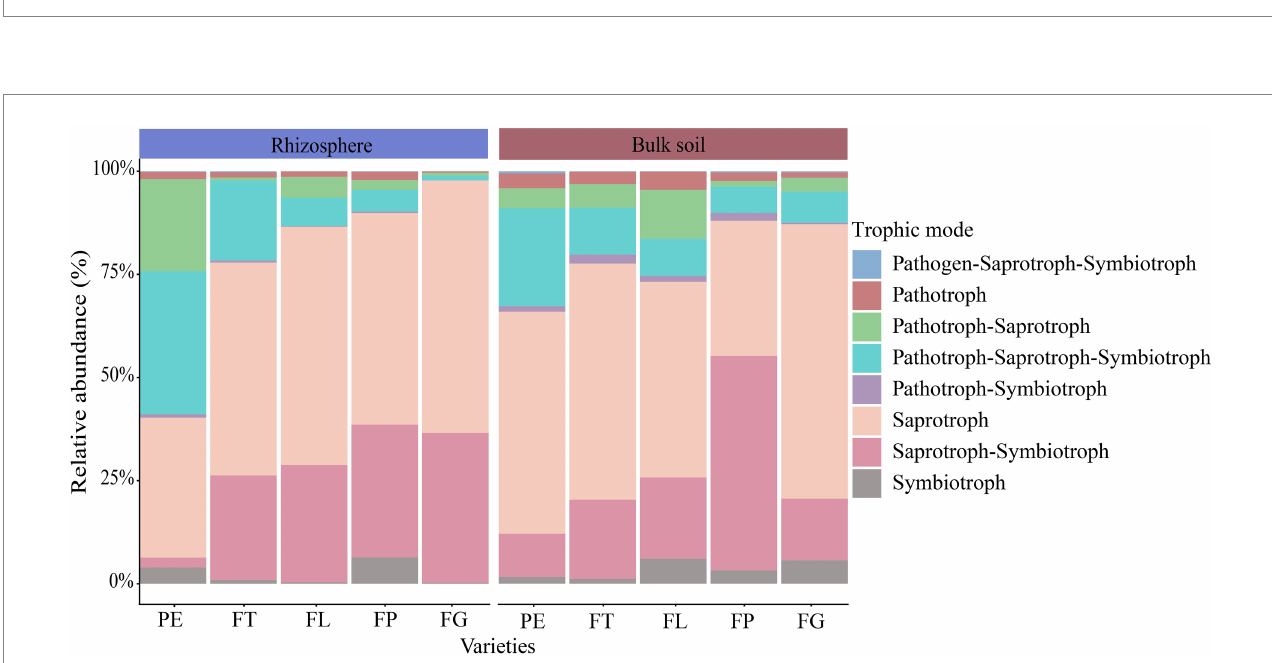
FIGURE 4 Effect of soil compartment on the co-occurrence network of fungal communities. Nodes and edges indicate genera and the strength of connections between genera, respectively, and different modules are represented by different colors.